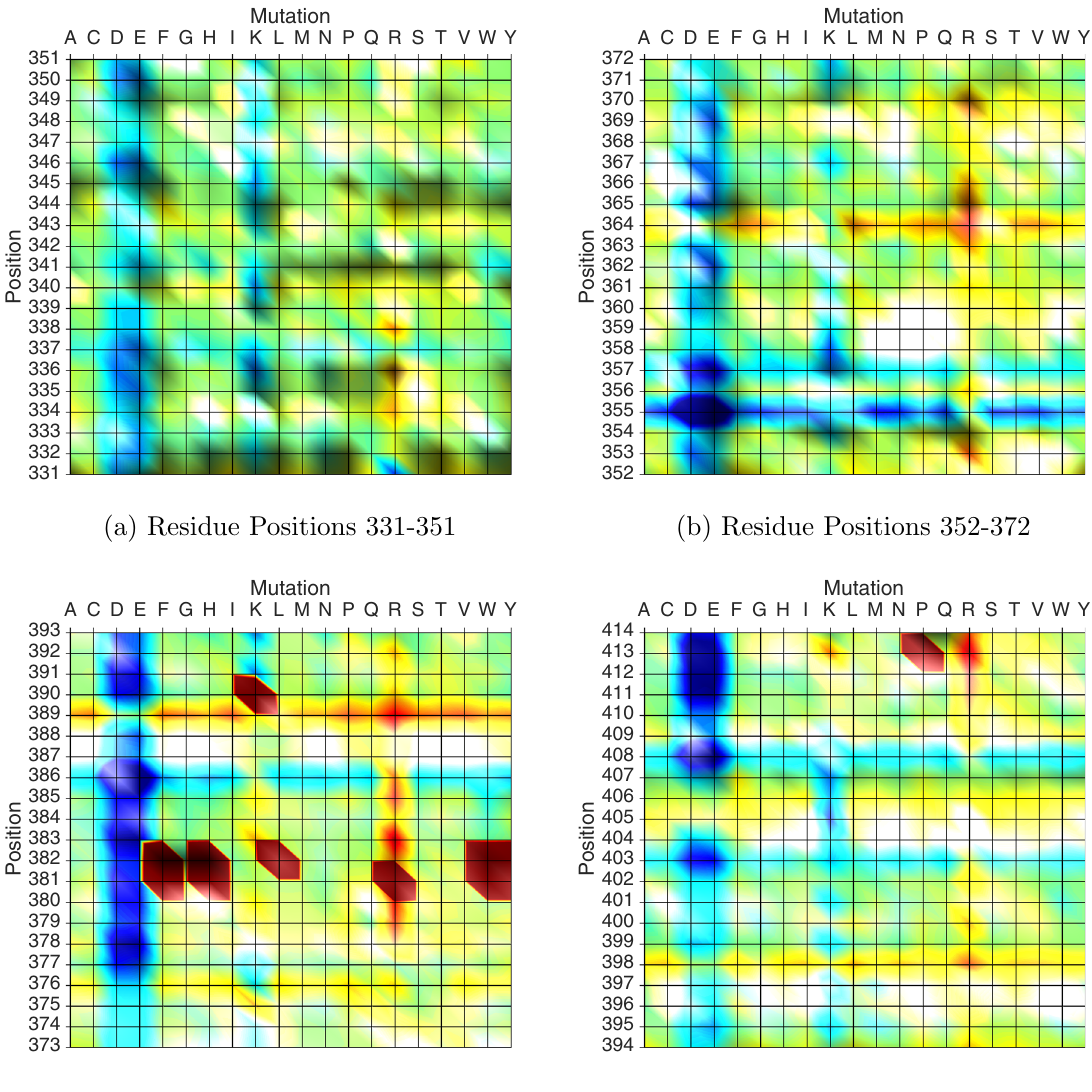
Figure 4. 2D Projection of the RBD Mutation Landscape. The introduction of a C or D mutation throughout most positions of the spike consistently suggests an improvement in the overall stability of the protein. Mutations in positions 355, 357, and 408 strikingly result in stable conformations. Positions 364 and 389 appear to be unstable spike regions. 2D Projection of the RBD Mutation Landscape. Positions 420, 427, 428, 444, and 465 appear to be unstable spike regions. On the other hand, positions 454, 462, 466, 501, and others colored in blue can exhibit mutations that stabilize the spike mutant structures, then it is possible that it will also show good results on many less stable ones. In light of this, ˜ E we utilized the energy values of the single-point landscape to generate estimated (cid:31) E values ( (cid:31) ) for 2-point ˜ E mutations. Using Eq. (4), we generated (cid:31) values for all possible 7.5 million 2-point mutations. Table 4 reports the top ten most stable 2-point mutations and Table S9 of the supplementary material reports the top 1000. ˜ E Although not exact, the (cid:31) values given by Eq. (4) are close approximations to the (cid:31) E values generated from full ˜ E atomic simulation runs. The margin of error of (cid:31) values was on average 6.5%. This method predicted that the 2-point mutation (R355D K424E) contributes strong structural stability to the spike protein and should be tested against potential vaccines and inhibitors. Other tools in the literature such as DynaMut2 40 , and PROVEAN 41 have also supported these findings. In Table 4, we report the change in binding affinity induced by mutation ( (cid:31)(cid:31) G ) of the top 2-point mutations run on DynaMut2. Positive and negative signs correspond to destabilizing and stabilizing mutations predicted to decrease and increase binding affinity respectively. The PROVEAN tool predicted that the top 2-point mutation (R355D K424E) might have an impact on the biological structure and function of the spike protein. To further explore the effect of the (R355D K424E) mutation on the spike’s structure and stability compared to the non-mutant native type, we ran molecular dynamics simulation of 50 nanoseconds on both the full